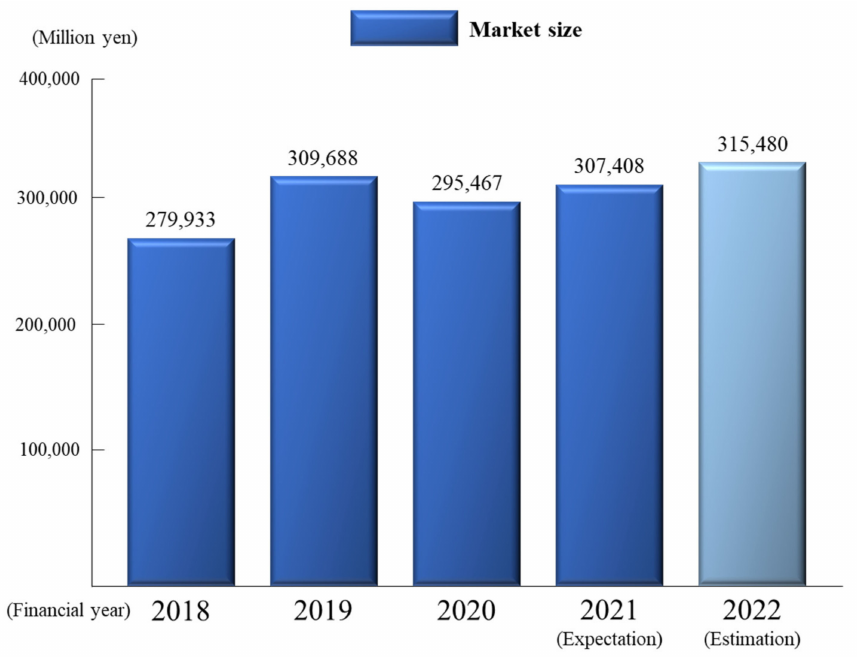
Figure 1. Trends and forecasts of the domestic outdoor equipment, facilities, and rental market